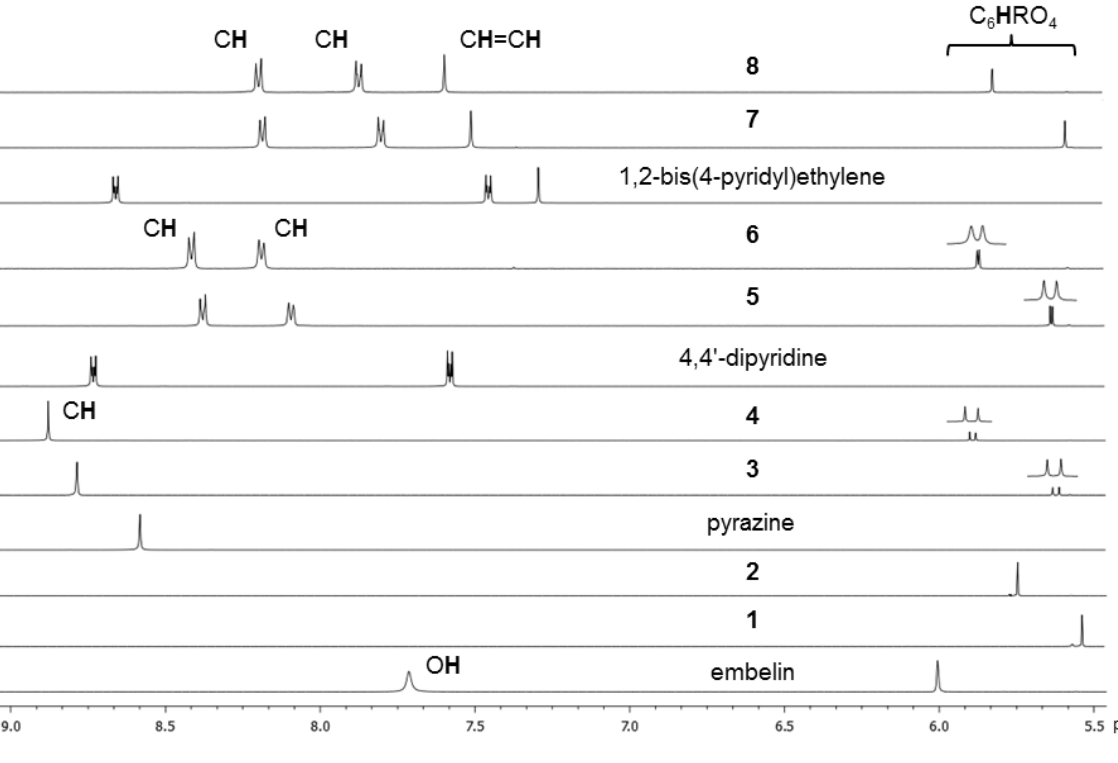
Cl , showing only the aromatic region. 2 2